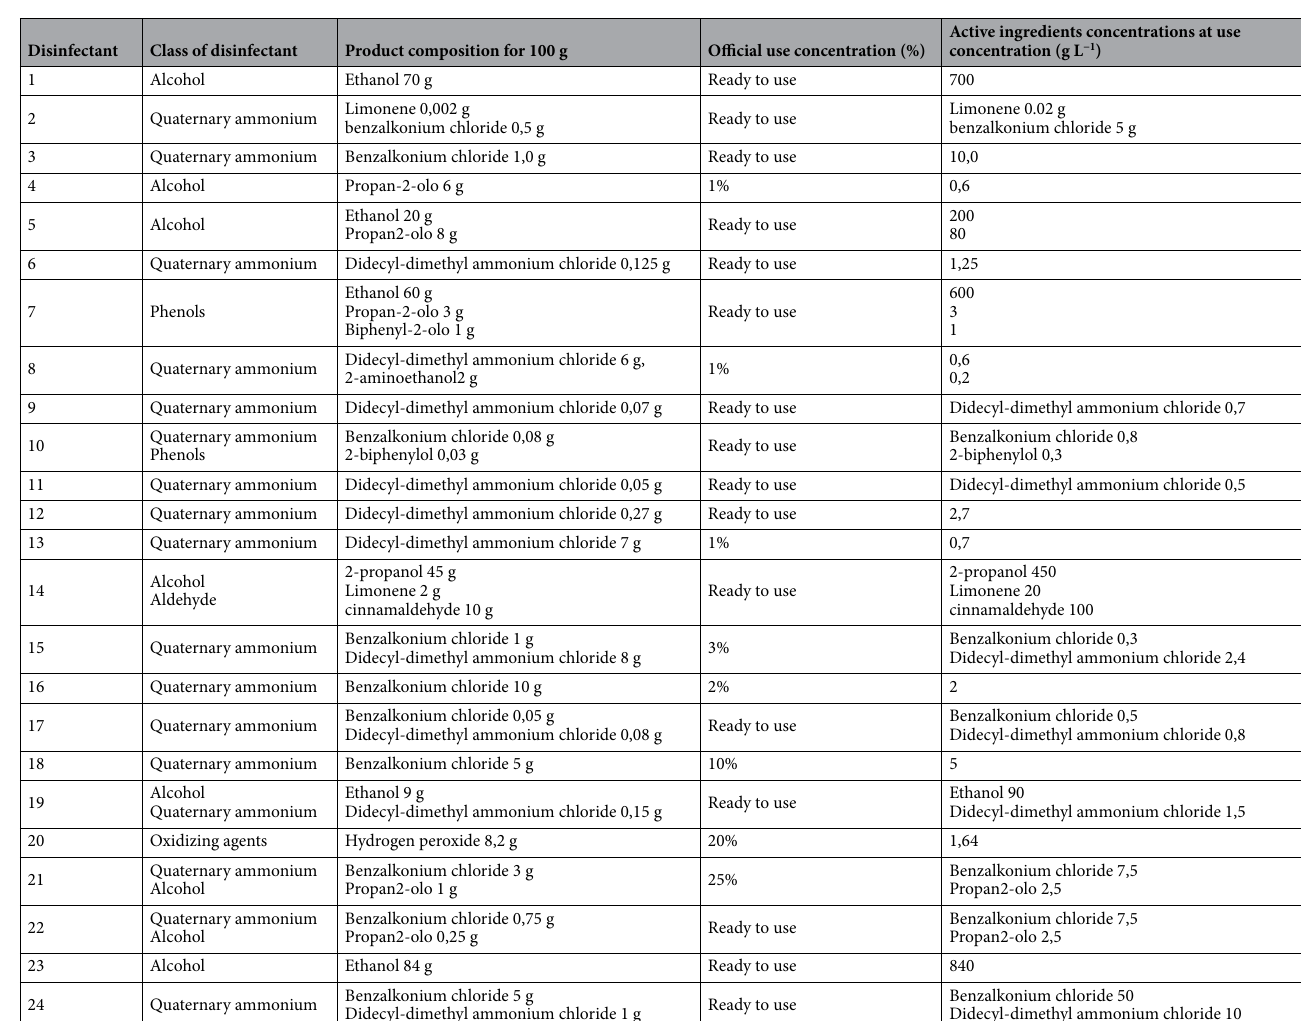
Table 1. Concentrations of active ingredients in the 24 disinfectants tested at the official use